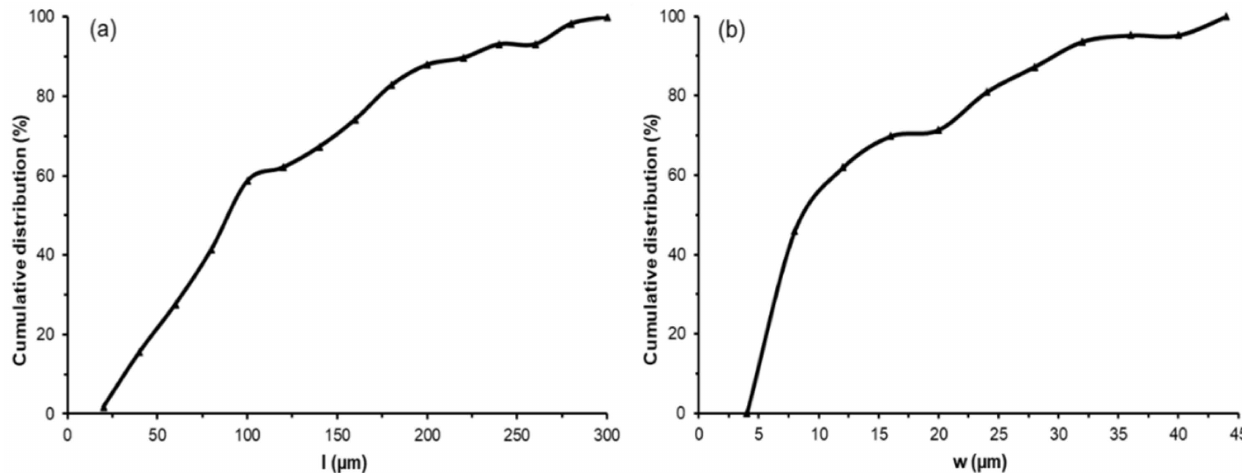
Figure 3. Cumulative distributions of cellulose microfiber (CMF) length ( l ) ( a ) and width ( w ) ( b ) obtained from image analyses of optical microscopy and field emission scanning electron microscopy (FESEM), respectively. A minimum of 60 measurements for each parameter was